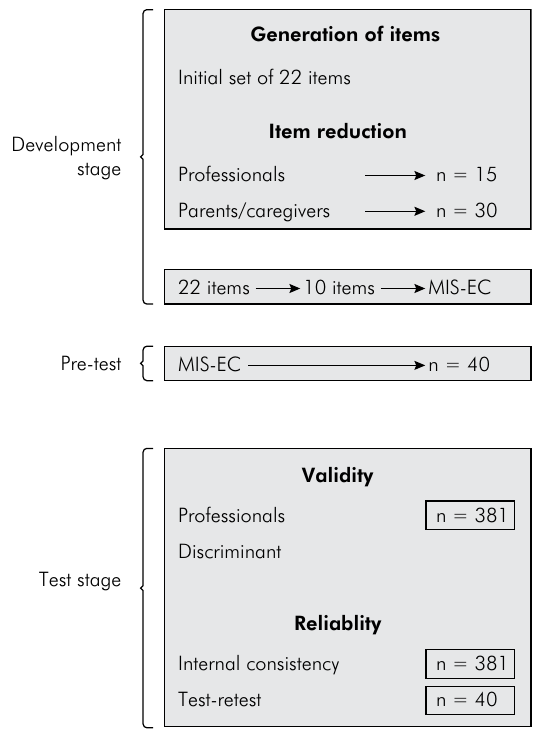
Figure 2. Flow chart describing the process of development and validation of the Malocclusion Impact Scale for Early Childhood (MIS-EC).